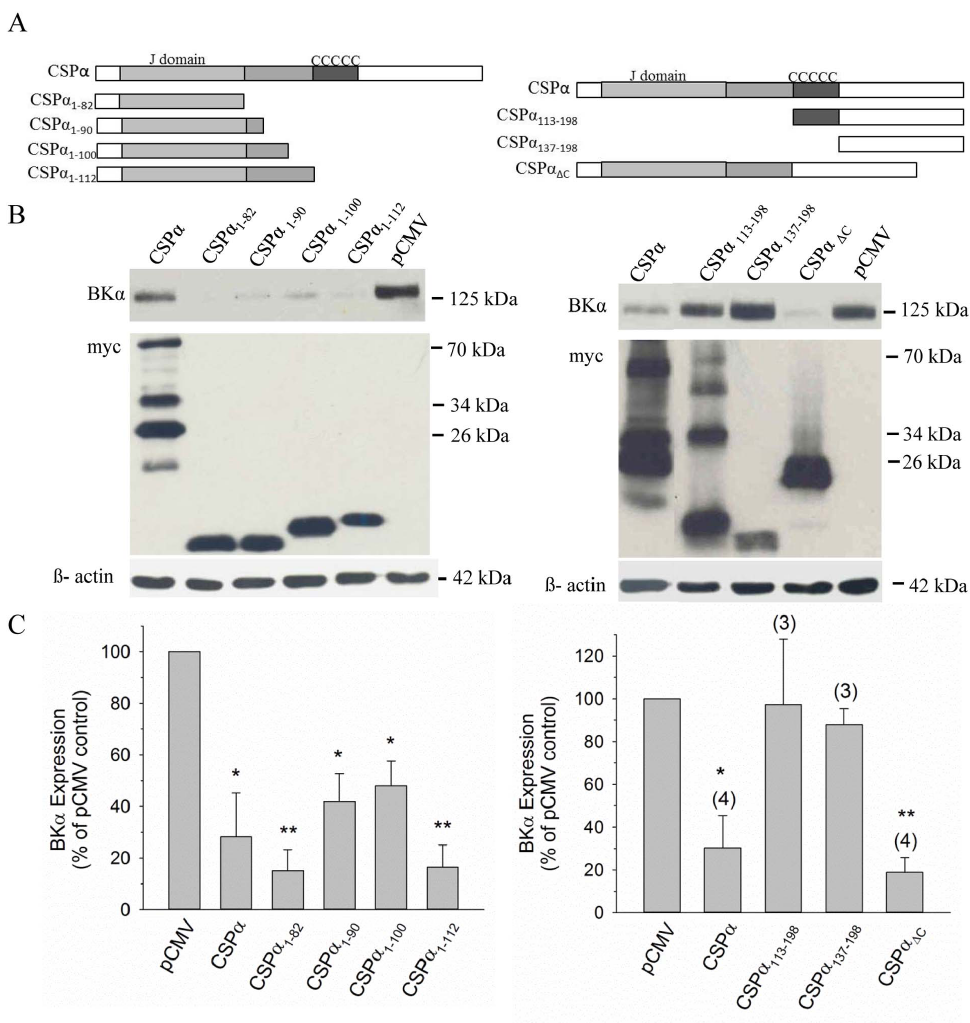
Figure 3. The J domain of CSP a reduces BK channel expression. A. Schematic of myc-tagged full length CSP a and CSP a deletion constructs. B. Western blot analysis of BK channel expression in CAD cells 24 h post-transfection with 1 m g cDNA encoding BK a subunit along with 0.75 m g myc- tagged full length CSP a cDNA or the indicated deletion constructs. As a transfection control, 0.75 m g empty pCMV was co-transfected with BK a subunit cDNA. 30 m g of cell lysate isolated under each experimental condition was separated by SDS-PAGE, probed with an anti-BK a subunit antibody and an anti-myc antibody. The histograms in panel C quantify changes in BK channel expression in the presence of wild-type CSP a and individual CSP a deletion mutants. Statistically significant differences from the pCMV control (set to 100%) were determined by one-way ANOVA; *p , 0.05; **p , 0.001.